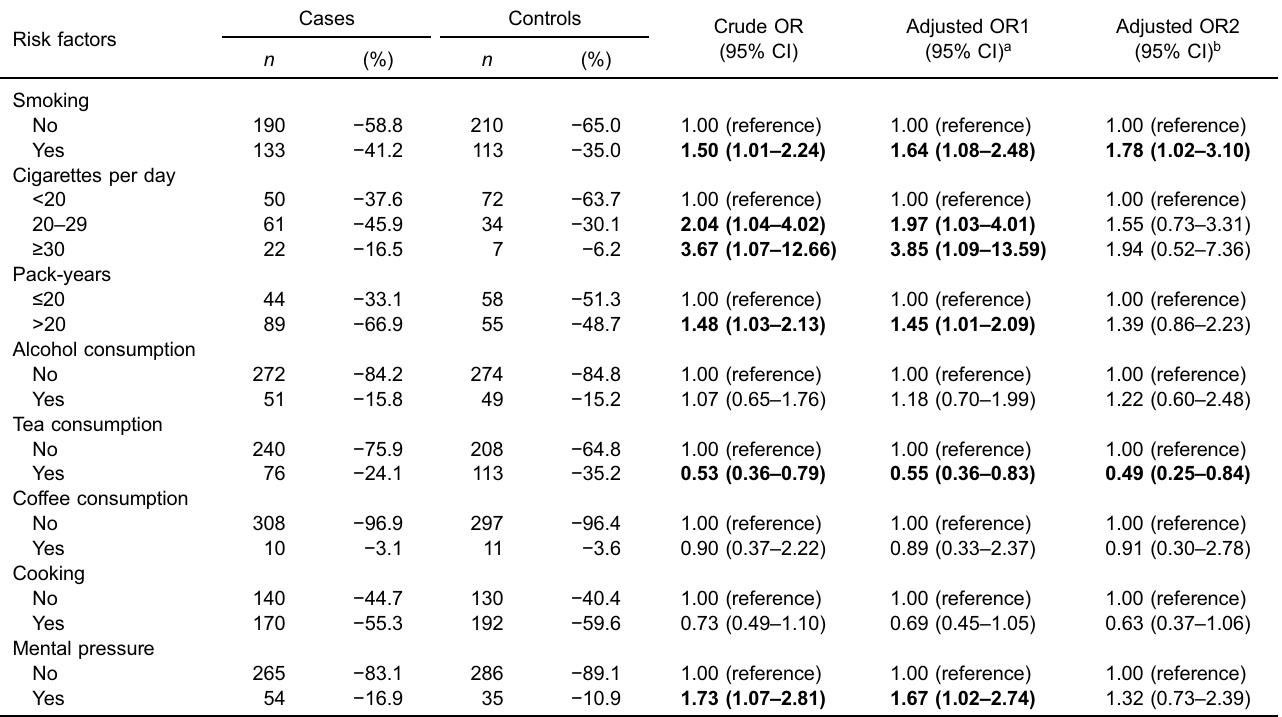
Table 2. Lifestyles associated with risk of pancreatic cancer Risk factors